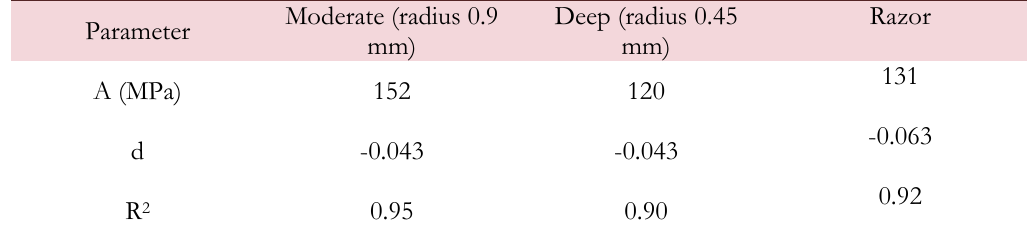
Table 2: S-N Basquin relationship constants. Data taken from Ref.